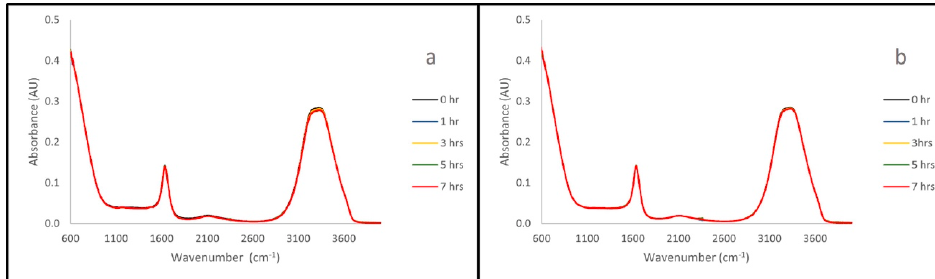
Figure 2. UV/Vis Time Lapse of B with 0.1 M HCl ( a ) and 0.1 M NaOH ( b ). Zero, one-, three-, five- and seven-hour UV- Vis time lapse of polymer B with exposure to 0.1 M HCl. The overlay of the spectra suggests that the polymer does not degrade over the course of the exposure.